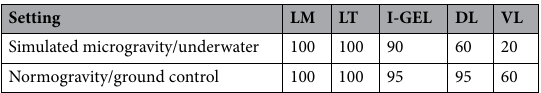
Table 1. Success rates (within 1 min) [%] in different groups.